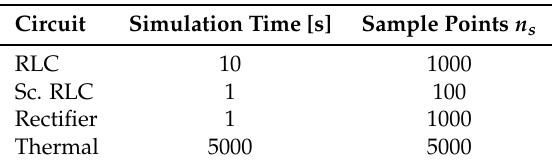
Simulation length and required number of equally spaced sample points for each benchmark problem.